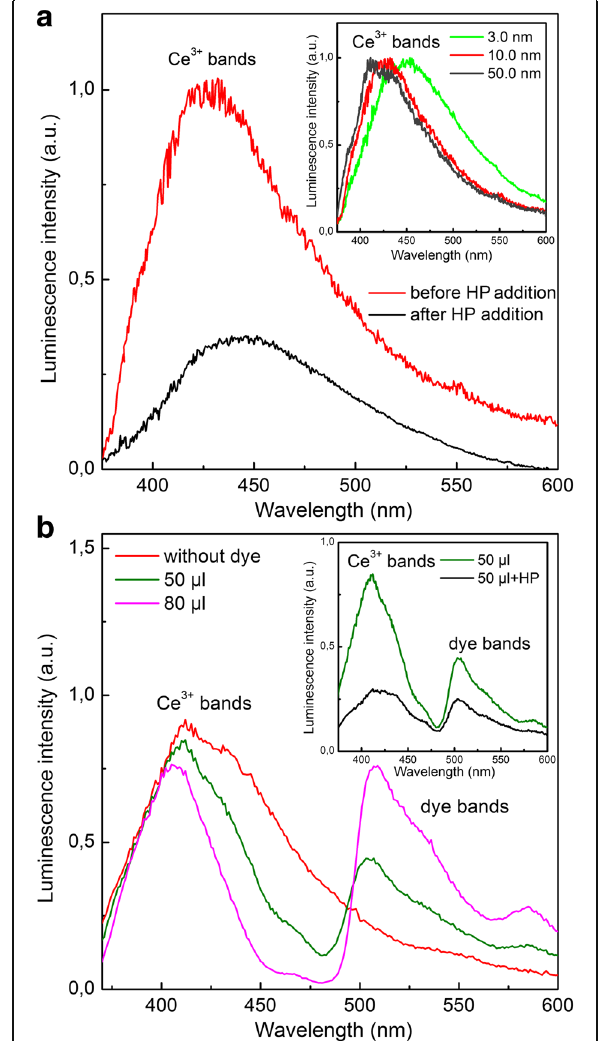
Fig. 1 Luminescence spectra of nanoceria under different conditions. a 10.0-nm nanoceria before and 25 min after HP ( C = 0.1 mM) addition. Insert: normalized spectra of different nanoceria samples. b Luminescence spectra of 10.0-nm nanoceria before and after addition of 50 and 80 μ l of dye. Insert: spectra of 10.0-nm nanoceria after addition of 50 μ l of dye and subsequent addition of HP ( C = 0.1